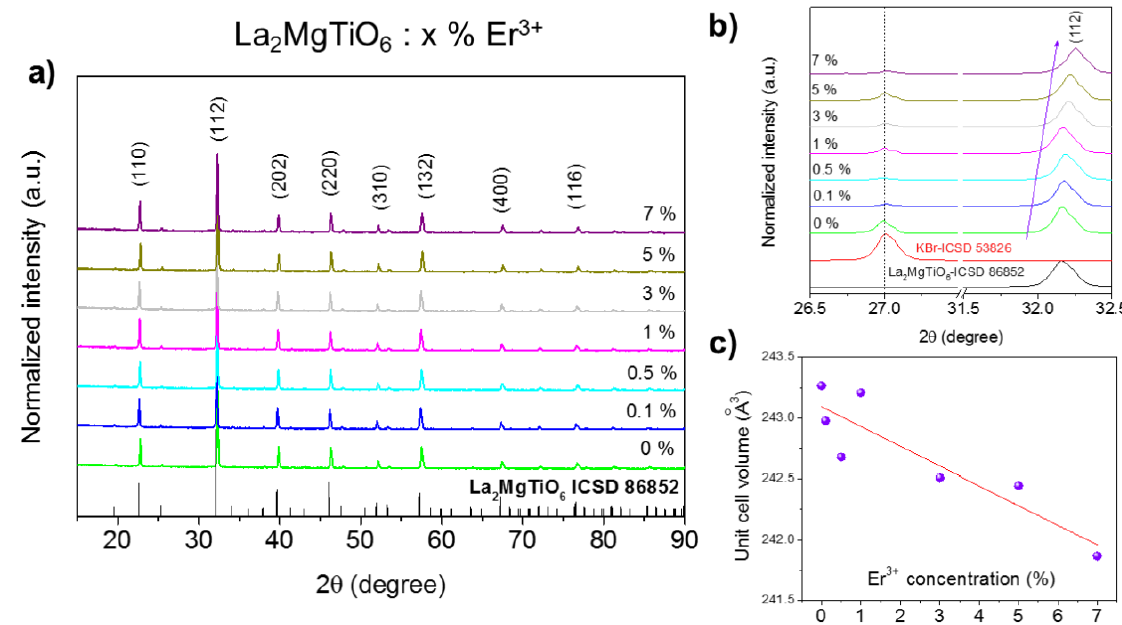
Figure 1. ( a ) X-ray powder diffraction of La 2 MgTiO 6 :x Er 3+ , (x = 0%, 0.1%, 0.5%, 1%, 3%, 5%, or 7%); ( b ) position correction of main diffraction peak of La 2 MgTiO 6 with the help of KBr; ( c ) changing of unit cell volume as a function of Er 3+ concentration (in the inset).